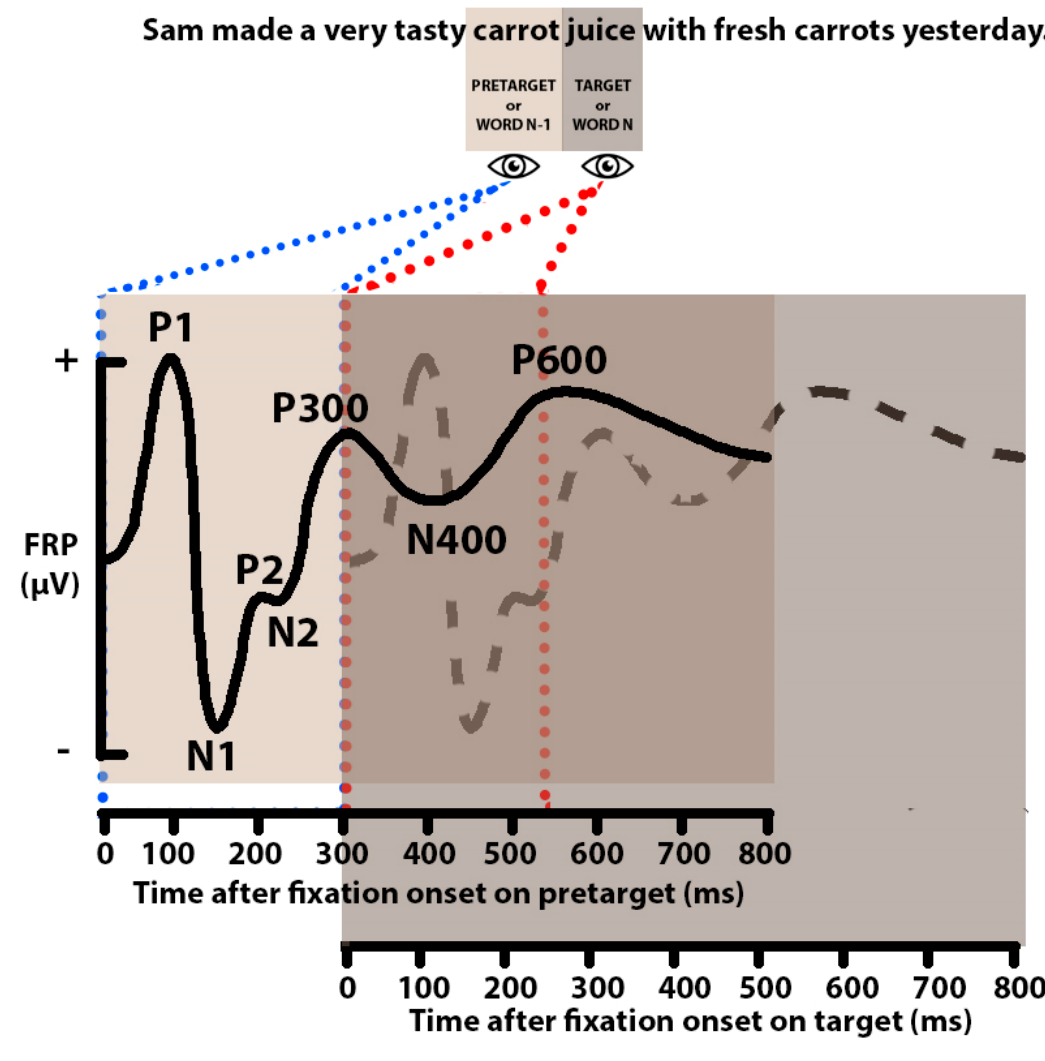
Figure 2. Here we offer a stylized characterisation of deconcolved waveforms that might (ideally) be revealed if deconvolution processes were applied successfully to an average FRP data stream recorded across two successive fixations made on the word “carrot” and then on the word “juice” as the sentence “John made a very tasty carrot juice with fresh carrots yesterday” was read. The solid black line represents the waveform and components (i.e., P1, N1, P2, N2, P300, N400, P600) that result from processes associated with the fixation on the pretarget word, and these have been separated from the waveform and components (dashed line) associated with the fixation on the target word. Note that the actual waveform that would be recorded during the experimental trial would be a convolved signal comprised of multiple waveforms deriving from fixations on the word(s) prior to the pretarget word, the target word (and potentially) the posttarget word (‘with’ in the current example). For simplicity, we have not included the convolved waveform in this figure, but the overlapping portion of the two panels (time-locked to fixation onset on pretarget and target words) shows where that convolved signal would occur (for only pretarget and target words) if it had been illustrated. See Ehinger and Dimigen (2019) [130]) for a discussion of deconvolution and its mathematical properties.